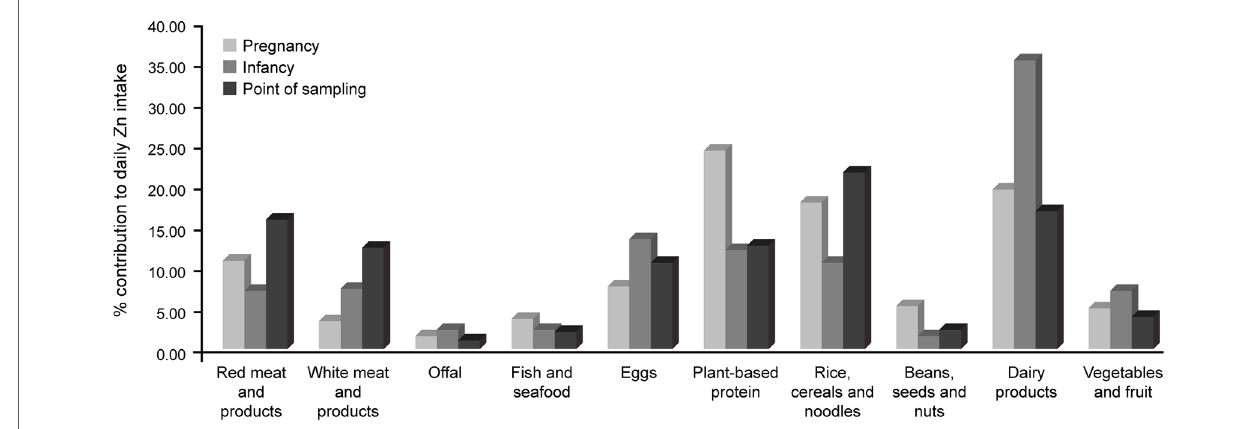
FIGURE 2 The contribution of different food groups to daily Zn intake of the study sample, measured using the S-FFQ, during pregnancy and – for children – infancy and the point of sampling.